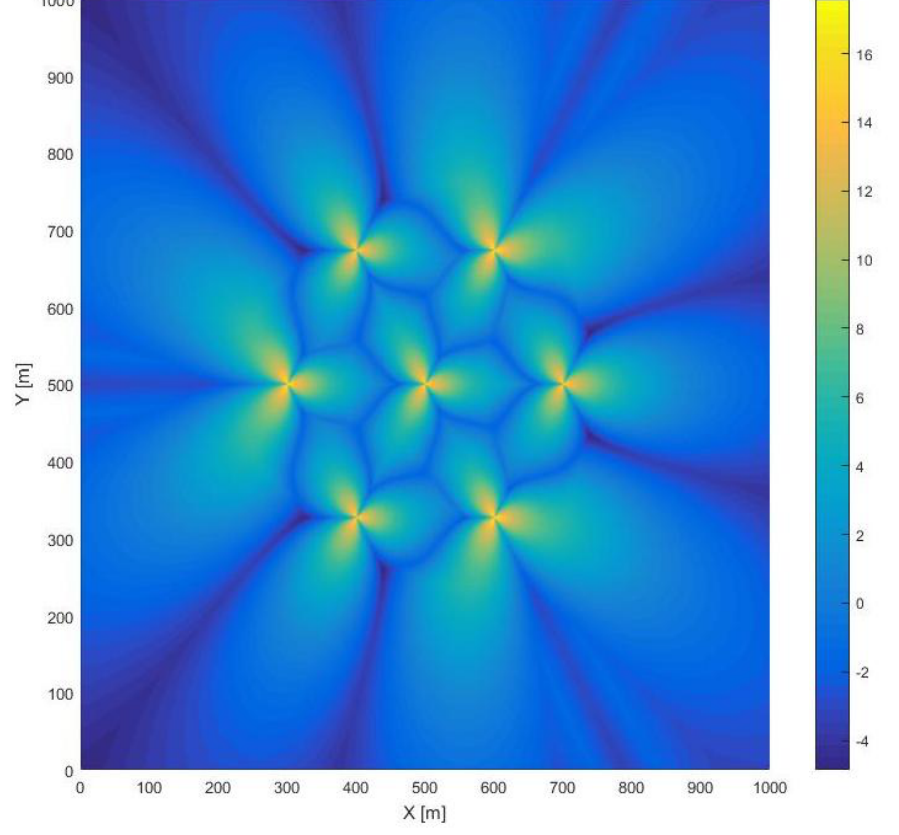
Figure 1. SINR geographical distribution for P = 20